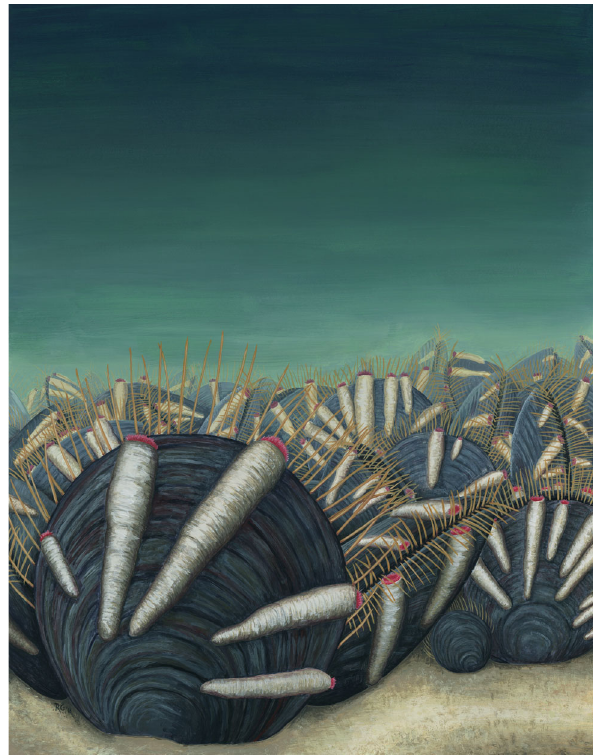
Fig. 4 Artist ’ s reconstruction of the Wulongqing Formation benthic community. Reconstruction shows the dense aggregations of monotypic Neobolus wulongqingensis forming benthic ‘ meadows ’ on the soft sediment with their associated obligate encrusting kleptoparasitic tube-dwelling organisms (Artist: Rebecca Gelernter of Near Bird